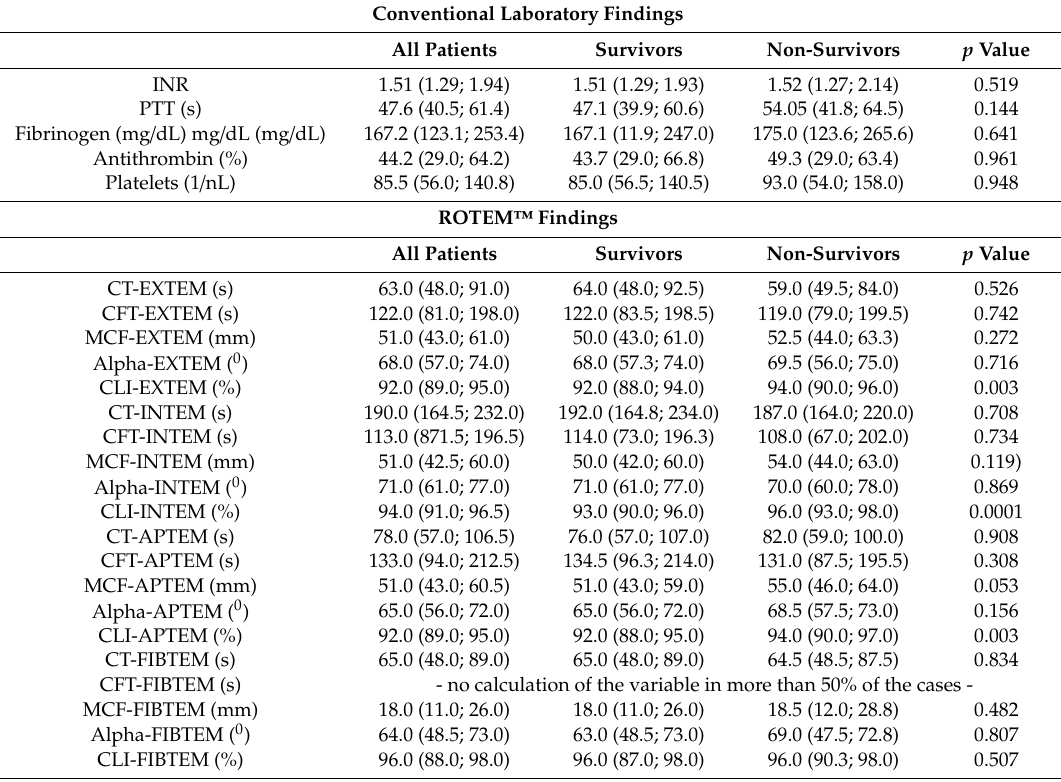
Table 2. Conventional laboratory parameters and rotational thrombelastometry (ROTEM ™ )-variables in patients presenting for liver transplantation. Shown are median and quartiles. The Wilcoxon test was used for evaluation of di ff erences between survivors and